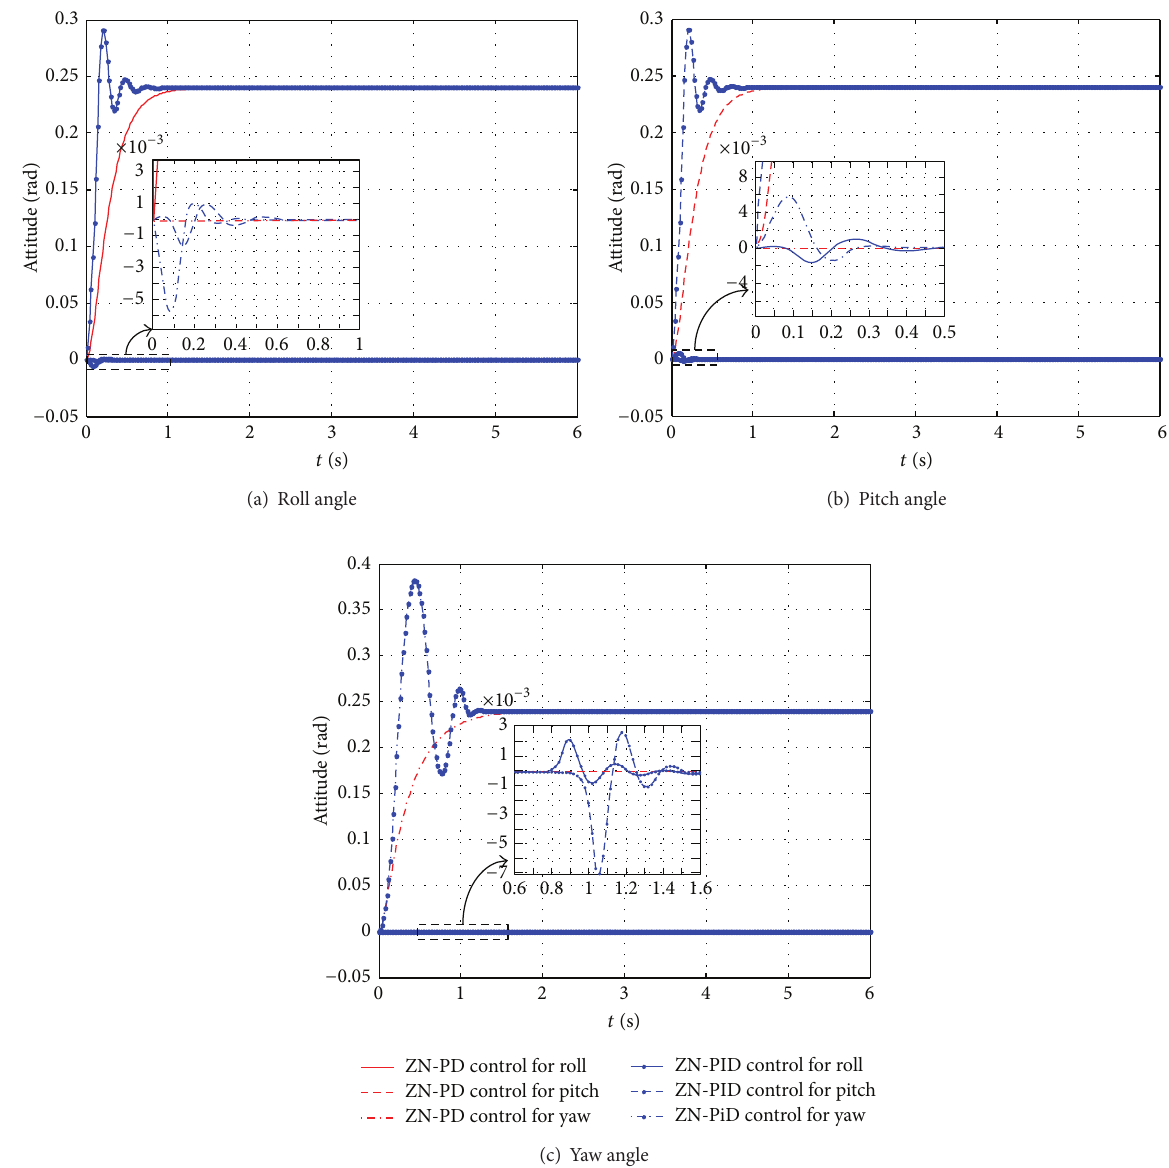
Figure 7: The control effects compare diagrams between ZN-PD and ZN-PID of separately controlling an attitude angle to the desired angle, while the rest attitude angles remain 0. (a) The control effects compare diagram of the roll angle. (b) The control effects compare diagram of the pitch angle. (c) The control effects compare diagram of the yaw